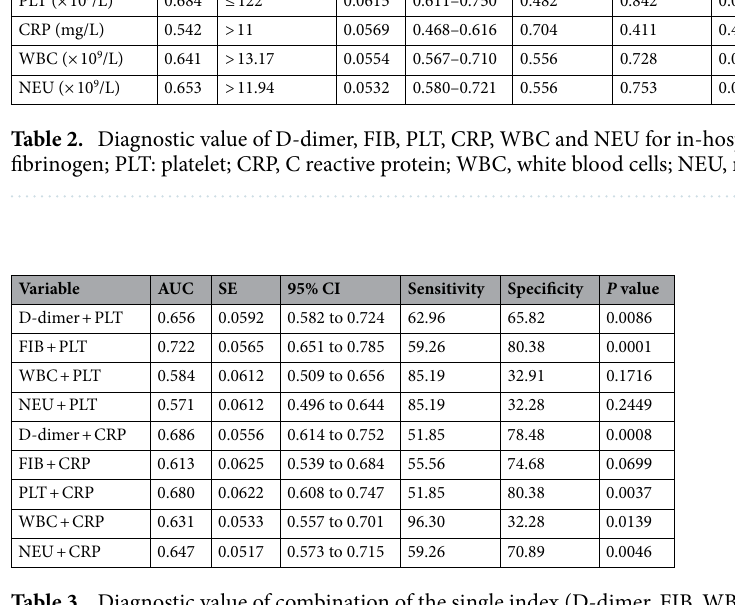
Table 3. Diagnostic value of combination of the single index (D-dimer, FIB, WBC, NEU) and PLT or CRP for in-hospital mortality. PLT, platelet; FIB, fibrinogen; WBC, white blood cells; NEU, neutrophil; CRP, C reactive